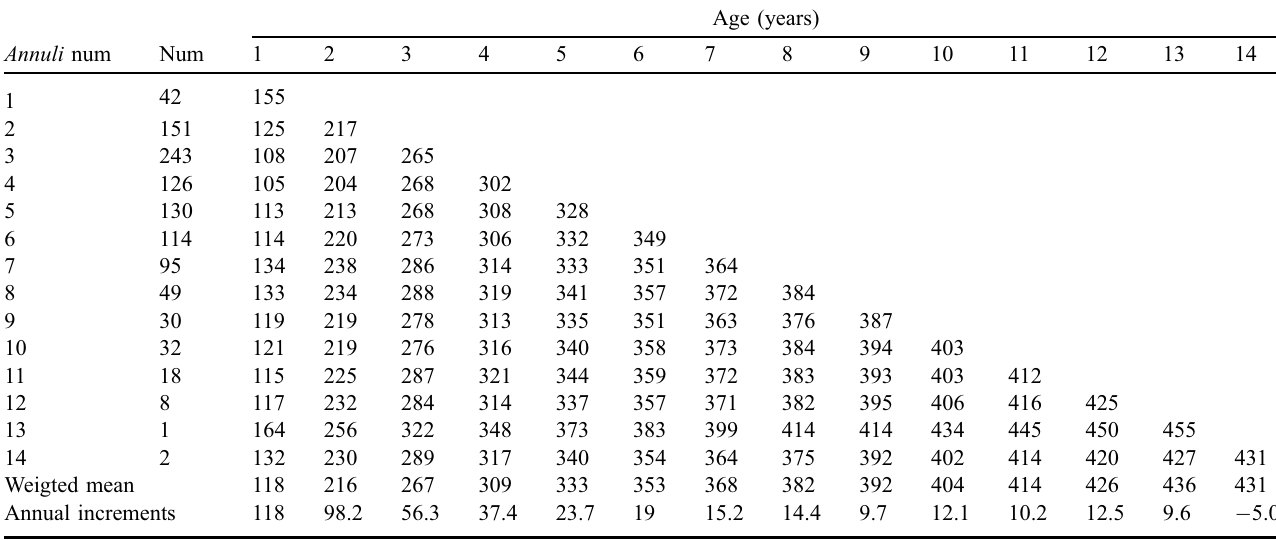
Table 4. Back-calculated total length (mm) at age of pooled sexes of Pagrus pagrus fi shed from 1976 to 1978 along southern